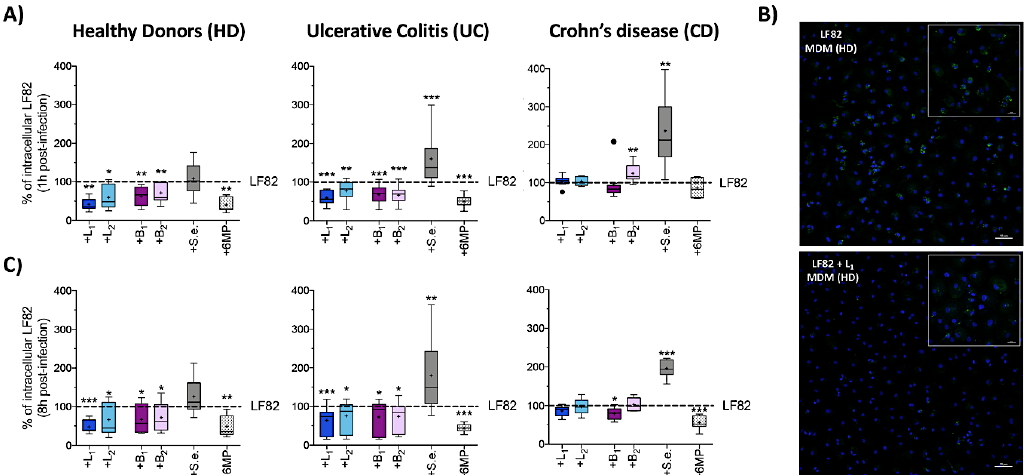
Figure 2. Effects of probiotic strains on phagocytosis and intracellular survival of AIEC-LF82 within human monocyte-derived macrophages (MDM). Percentage of internalized AIEC-LF82 cells within MDM derived from HD, UC or CD patients after 1 h ( A ) or 8 h of infection ( C ) with LF82 alone (taken as 100%) or in coinfection with Lactobacillus acidophilus LA1 (+L 1 ) or Lactobacillus paracasei 101/37 (+L 2 ) or Bifidobacterium animalis spp. lactis Bi1 (+B 1 ) or Bifidobacterium breve Bbr8 (+B 2 ) or S. epidermidis ATCC-155 (+S.e.), at 1:1 ratio or in the presence of 6MP (2 µg/mL). Each experiment was performed in triplicate and data are represented as described in Figure 1. Statistical significance for each condition compared to MDM infected with LF82 alone was reported (* p < 0.05, ** p < 0.01, *** p < 0.001); ( B ) confocal microscopic examination of HD-derived MDM infected with AIEC-LF82 alone or in coinfection with L. acidophilus LA1 (+L 1 ) at 1 h post infection. Cell nuclei (stained by DAPI) are shown in blue and AIEC-LF82 in green. Larger images: magnification 200×, scale bars: 50 µm. Smaller images: magnification 630×, scale bars: 20 µm.